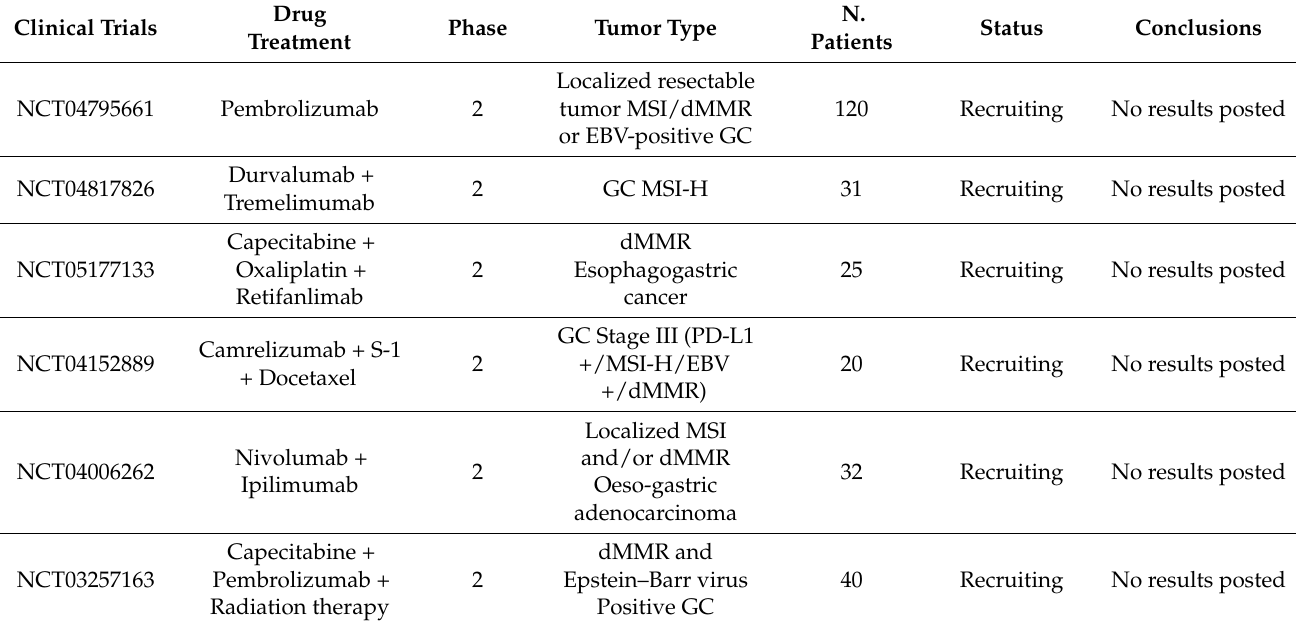
Table 3. Clinical trials for immune checkpoint inhibitors treatment of MSI